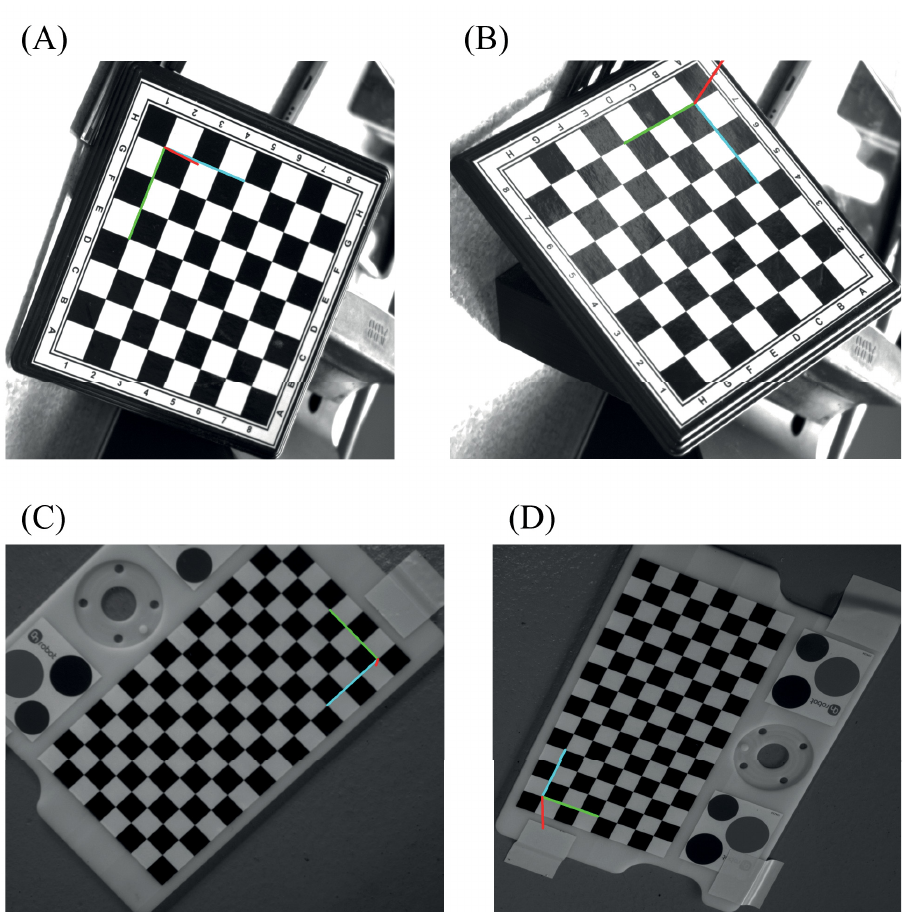
Fig 3. Change in position of origin (red, green, and blue axes) with change in orientation of target for an odd number of rows and columns. (A) Origin at position 1H. (B) Origin at position 7A. (C) Origin at the bottom right. (D) Origin at the bottom right after